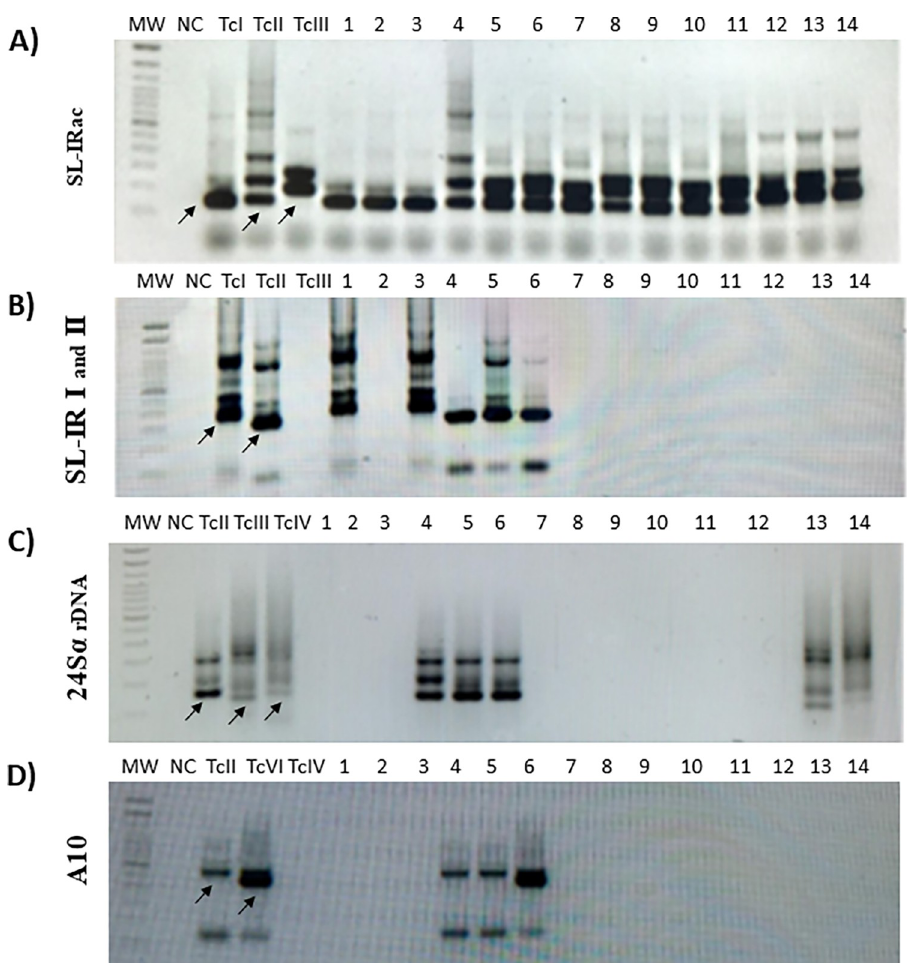
Fig 2. Representative gels of amplified gene products to define Trypanosoma cruzi DTU’s. Genes: A) the SL-IRac; B) the SLIR I and II; C) the 24S α rDNA and D) A10. (MW—Molecular Weight marker; NC—Negative control; Positive controls, amplified products of reference strains: TcI: Colombiana; TcII: Y; TcIII: X109/ 2; TcIV: CANIII cl1; TcV: Bug2148 cl1; TcVI: CL Brener. The numbers indicate the code of the sample. Patient’s sample and infecting